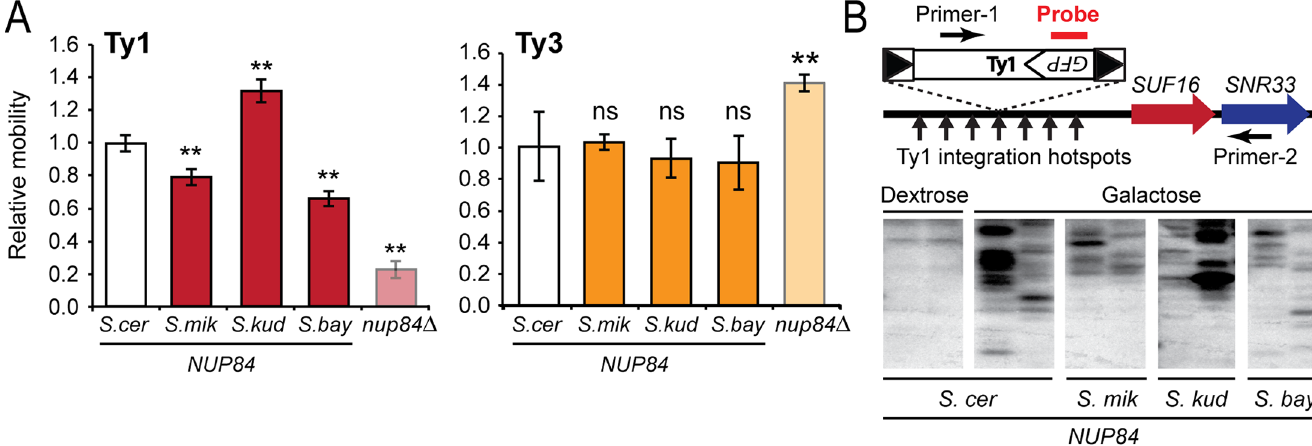
Fig 5. Evolutionary differences between NUP84 of different Saccharomyces species alter levels of Ty1 mobility. (A) Relative mobility of Ty1 and Ty3 within nup84 Δ or nup84 Δ complemented with heterospecific NUP84 from different Saccharomyces species. Asterisks designate complemented strains that have significantly different levels of mobility compared to the strain encoding NUP84 from S . cerevisiae (Tukey–Kramer method, p < 0.05) (error bars: standard error, n > 3). (B) Southern blot analysis of Ty1 integration in two independent clones upstream of the SUF16 locus, which contains Ty1 integration hotspots in its promoter [73]. PCR products across the SUF16 locus were run on a gel and then probed with a radiolabeled DNA probe specific to GFP in order to detect integration events.